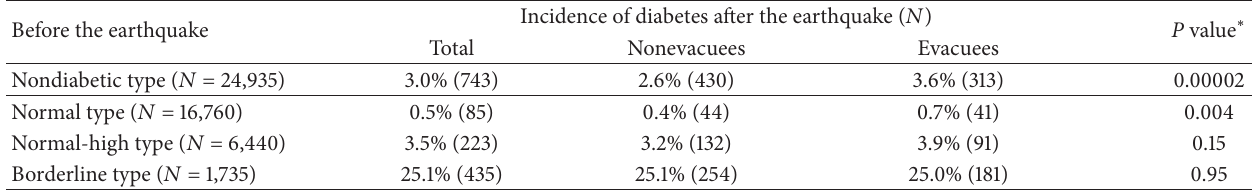
Table 5: The incidence of diabetes after the Great East Japan